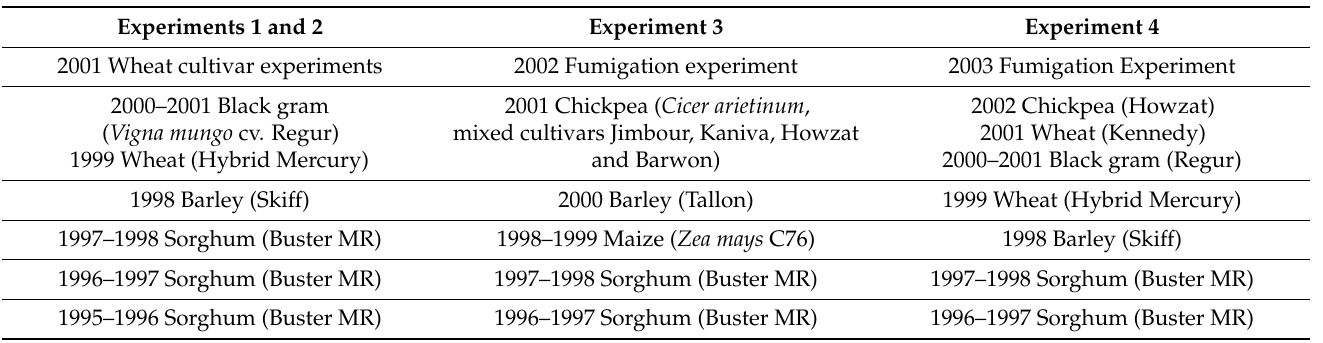
Table 2. Cropping histories of the field sites used for the experiments. Cultivar names are in parentheses. Experiments 1 and